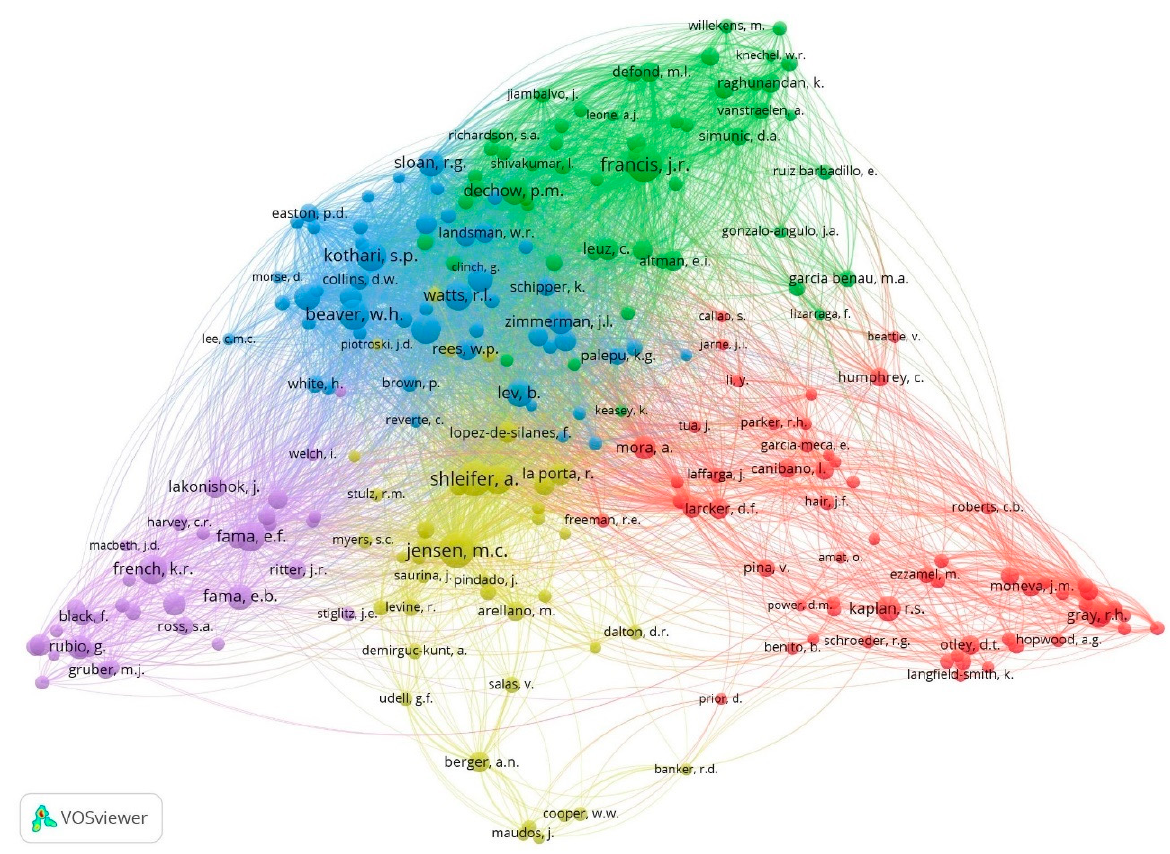
Figure 6. Network of Author Co-citation on SJFA.